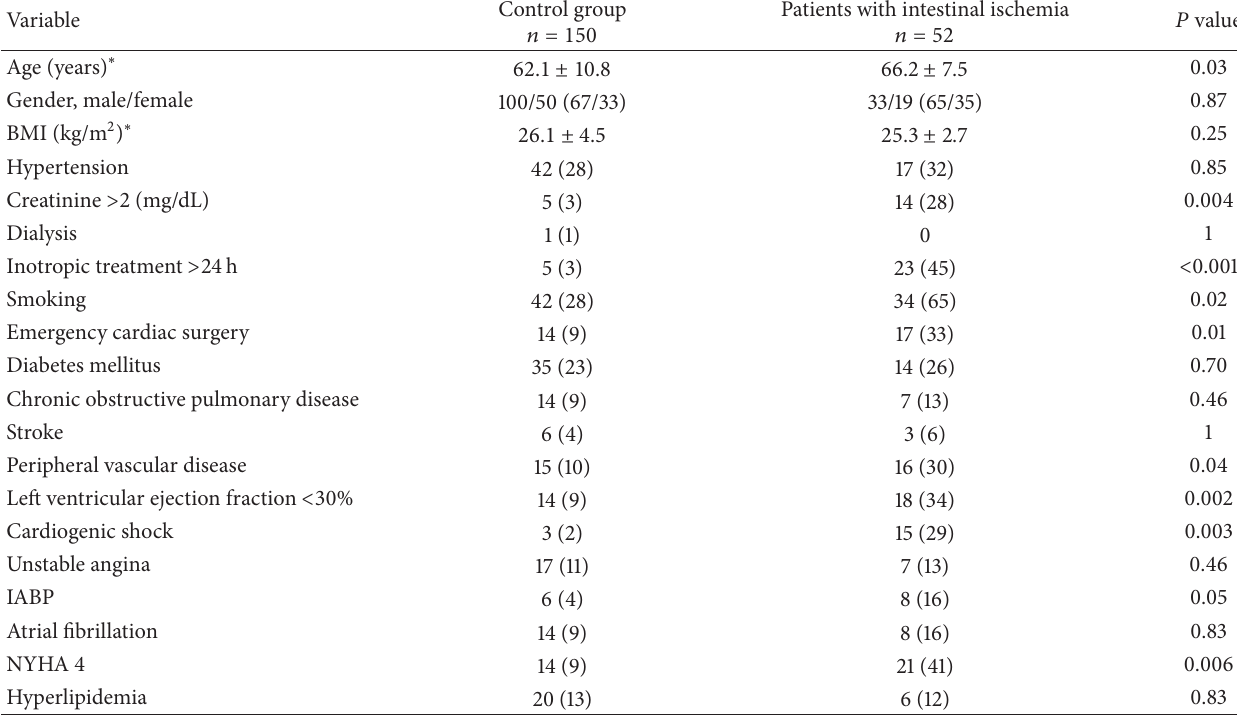
Table 1: Preoperative values for intestinal ischemia after cardiac